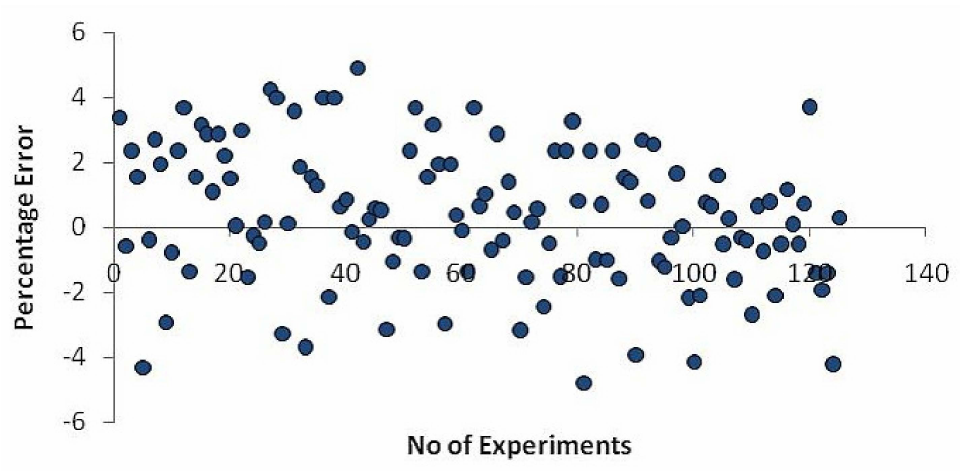
Figure 16. Network 4-4-3 error graph for angular distortion with a time gap between four